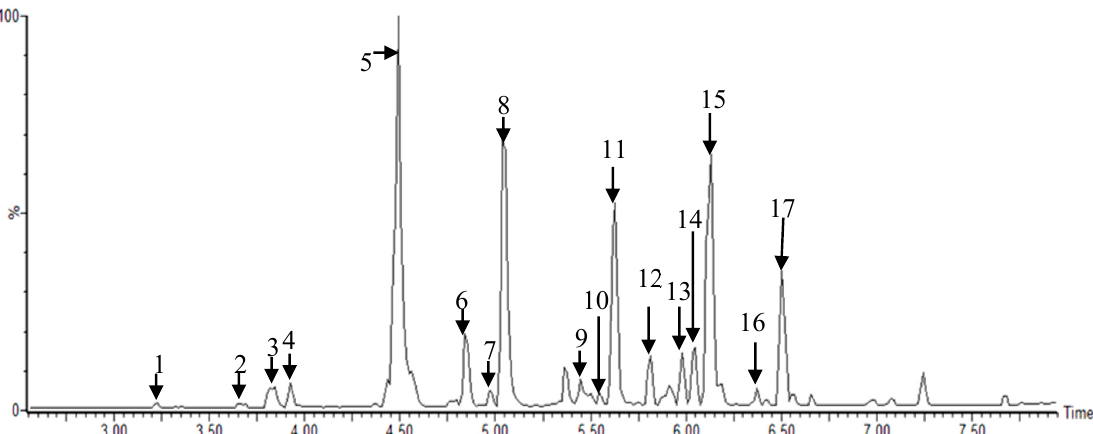
Figure 1. Representative ultra-performance liquid chromatography–quadrupole-time-of-flight mass spectrometry (UPLC–Q-TOF MS) profiles of Morus root cultivars: 1, kuwanon X / Y / P; 2,